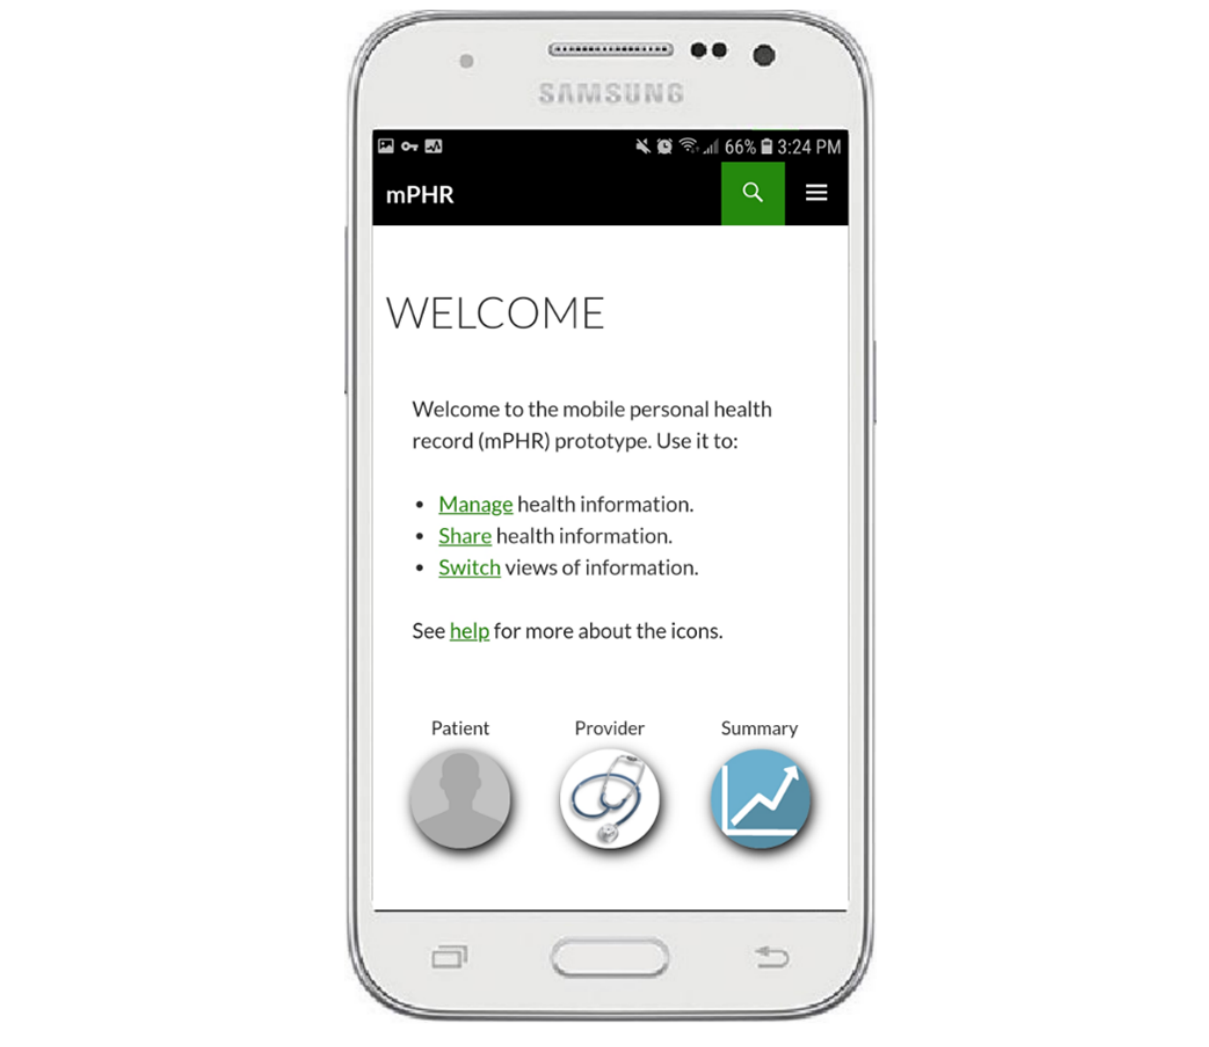
Figure 3. Example Samsung Galaxy Prevail LTE showing the patient and provider buttons. The screen background provides an additional visual cue